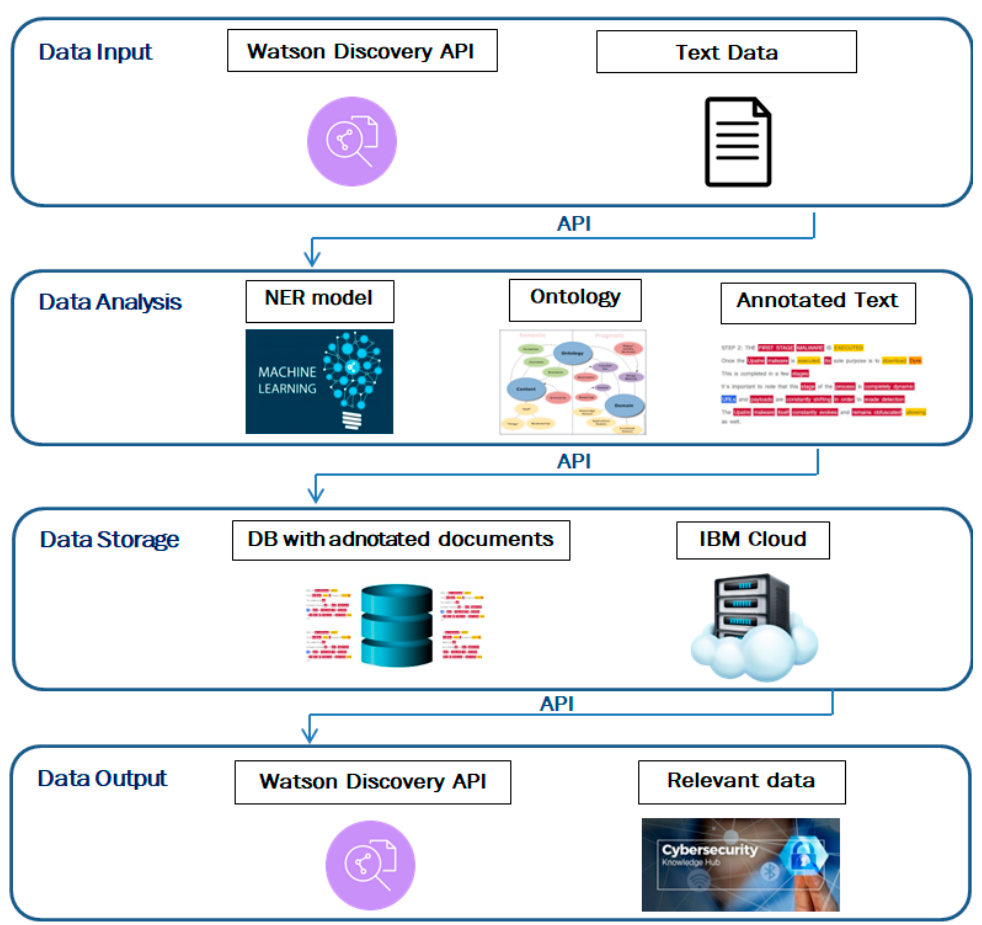
Figure 2. The solutions’ architecture with the four levels of data processing